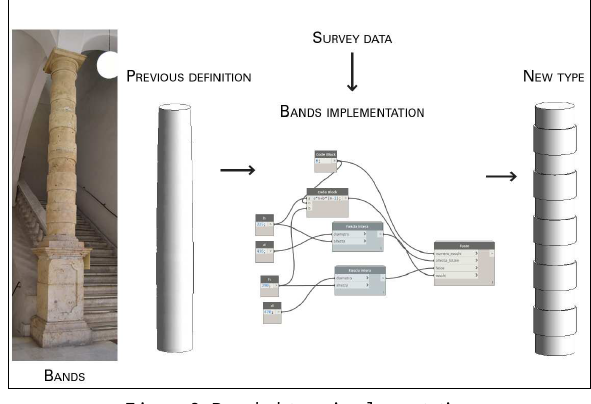
Figure 8. Banded type implementation